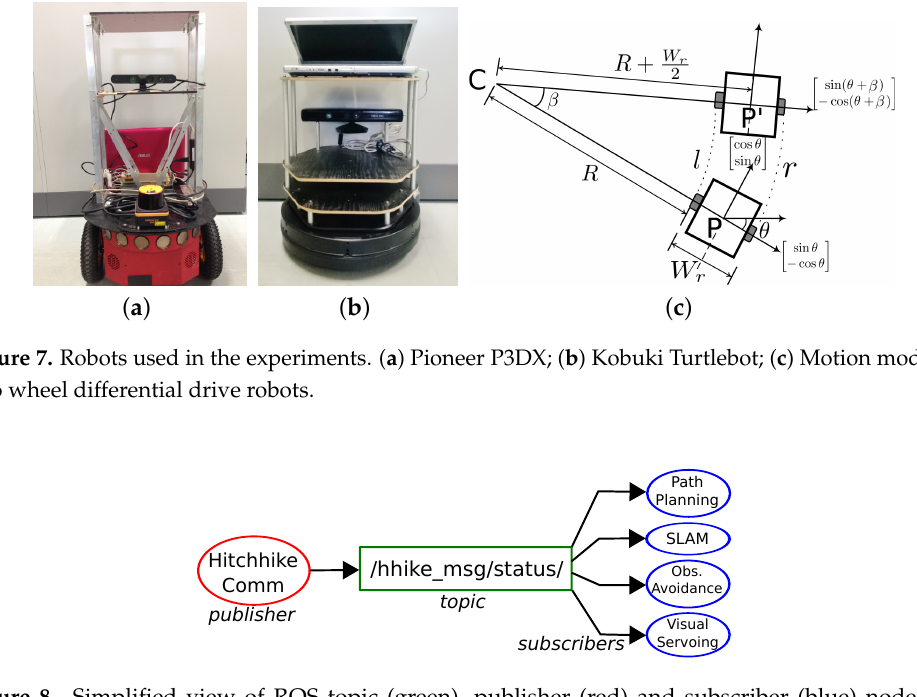
Figure 8. Simplified view of ROS topic (green), publisher (red) and subscriber (blue) nodes for module